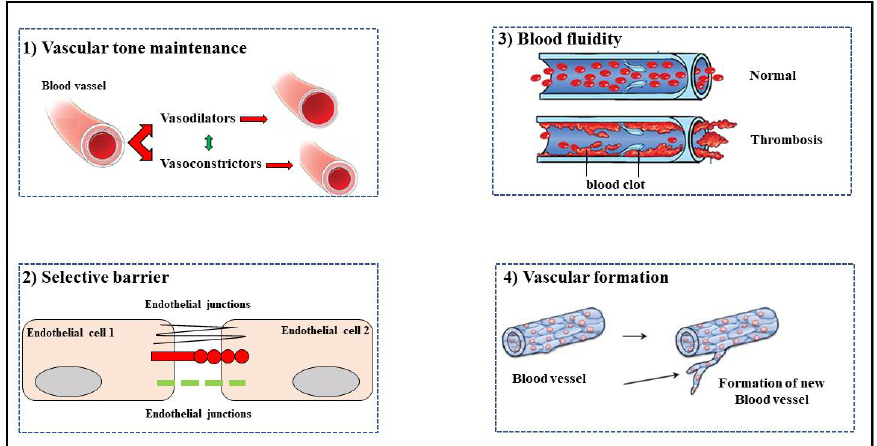
Figure 2. Representation of some endothelium functions.